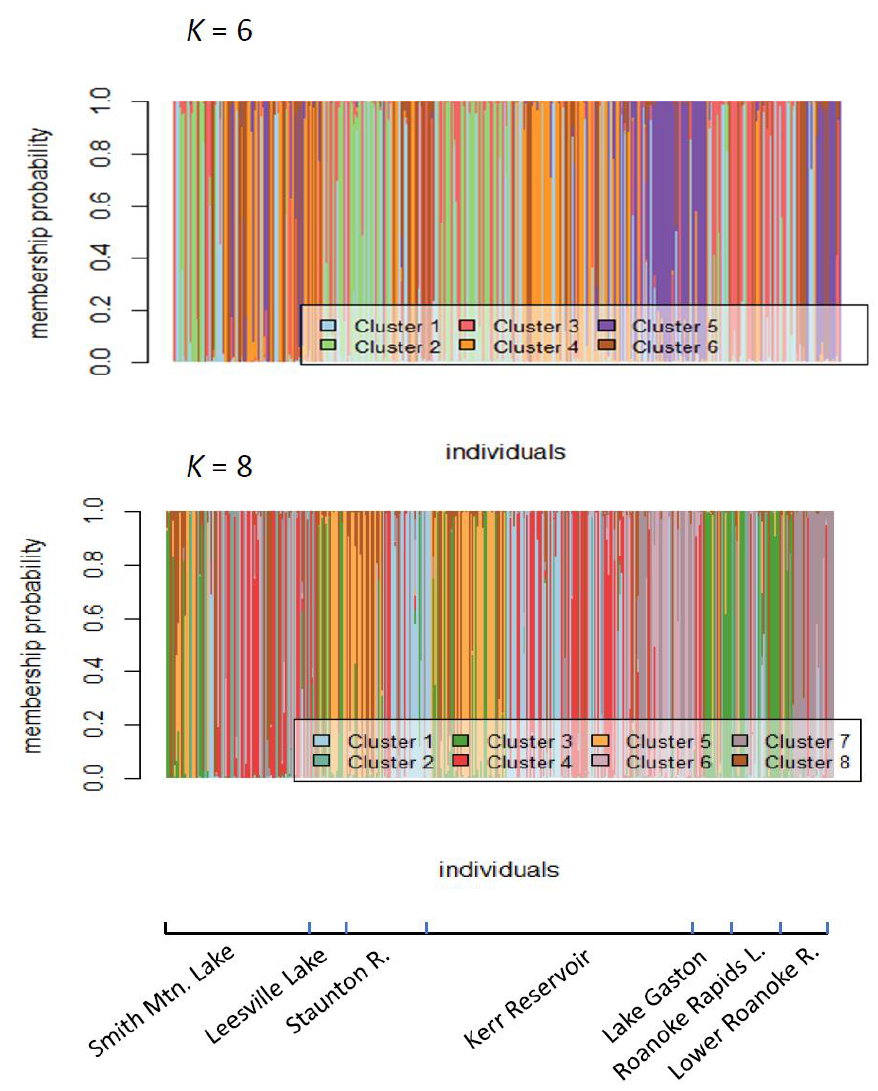
Figure 5. DAPC plot for 489 striped bass from seven collections in the Roanoke basin, respectively grouped into K = 6 and K = 8 clusters.